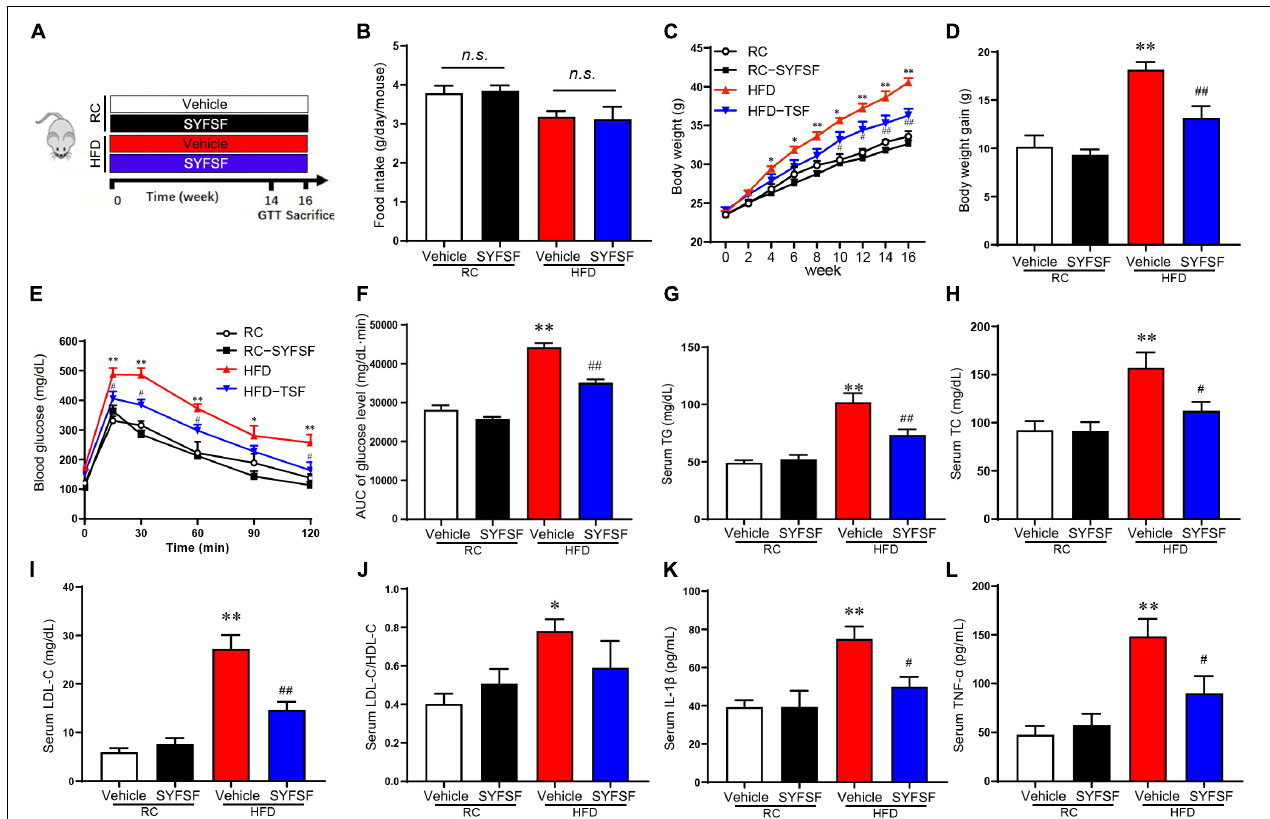
FIGURE 1 | SYFSF prevents weight gain, insulin resistance and low-grade inflammation in HFD-fed mice. (A) A schematic diagram for the experimental timeline. (B) Food intake. (C) Body weight. (D) Body weight gain. (E) GTT results. (F) Area under the curve. (G–L) Serum TG, TC, LDL-C, LDL-C/HDL-C, IL-1 β , and TNF- α . ∗∗ P < 0.01, ∗ P < 0.05 vs. RC; ## P < 0.01, # P < 0.05 vs. HFD. n.s, not significant. n = 6 per